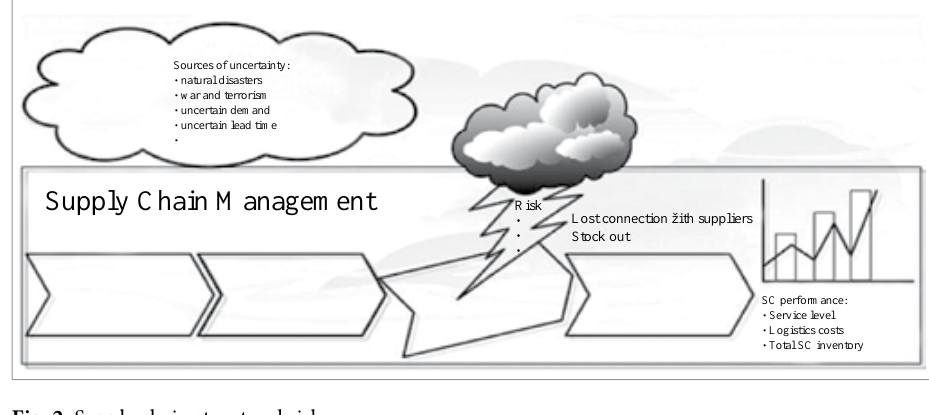
Fig. 2. Supply chain structural risk Table 1. Sources of uncertainty in supply chains